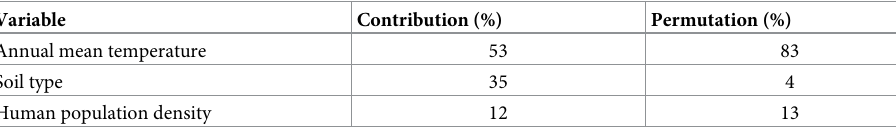
Table 2. Contribution of the three environmental predictors to the final suitability